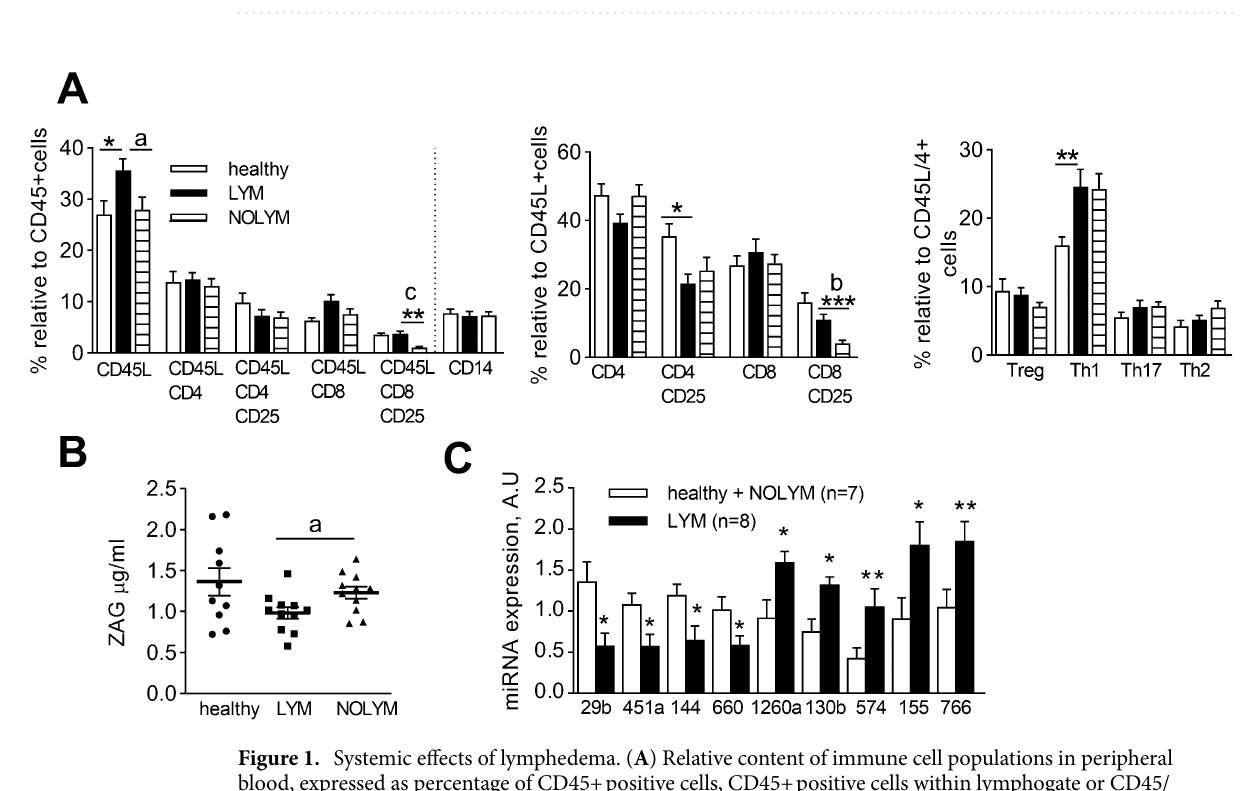
Table 1. Anthropometric and biochemical characteristics of the subjects. Data are shown as mean ± SD. *p < 0.05, **p < 0.01, ***p < 0.001 (difference related to healthy subjects).